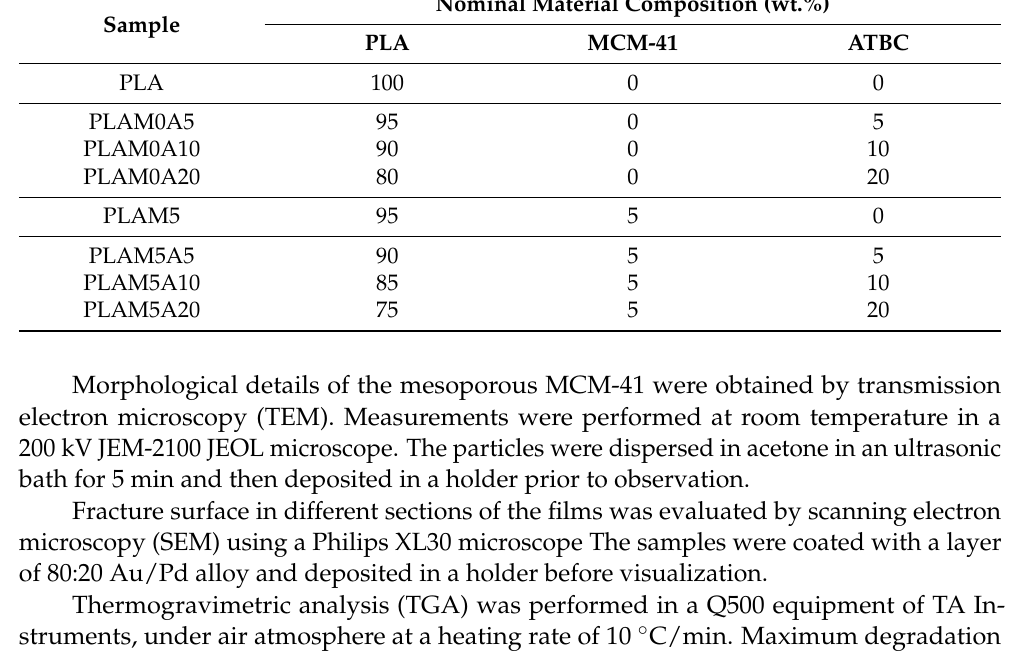
Table 1. Specimen labels and nominal composition for the different materials under study.